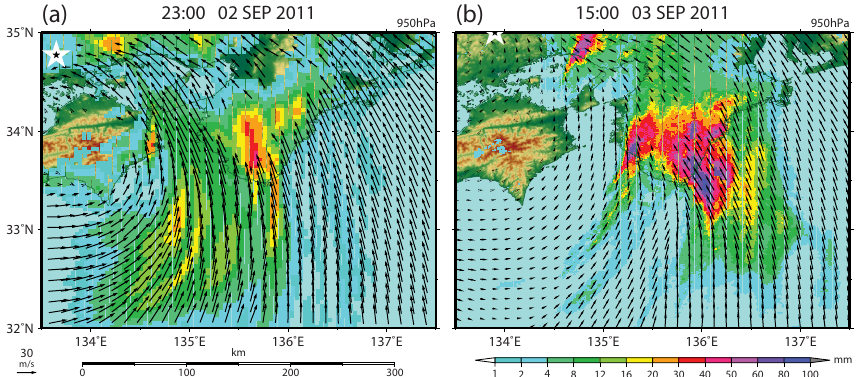
Figure 7. (a) Simulated hourly rainfall amount and wind field on 950hPa level at 23:00UTC on 2 September from D2 of NOPVI, (b) ob- served RAP and analyzed wind field produced by the JMA/MSM (Meso Scale Model) at 15:00UTC. These are when the typhoon made landfall again at the Chugoku region of western Japan, the location is depicted by the star symbol.